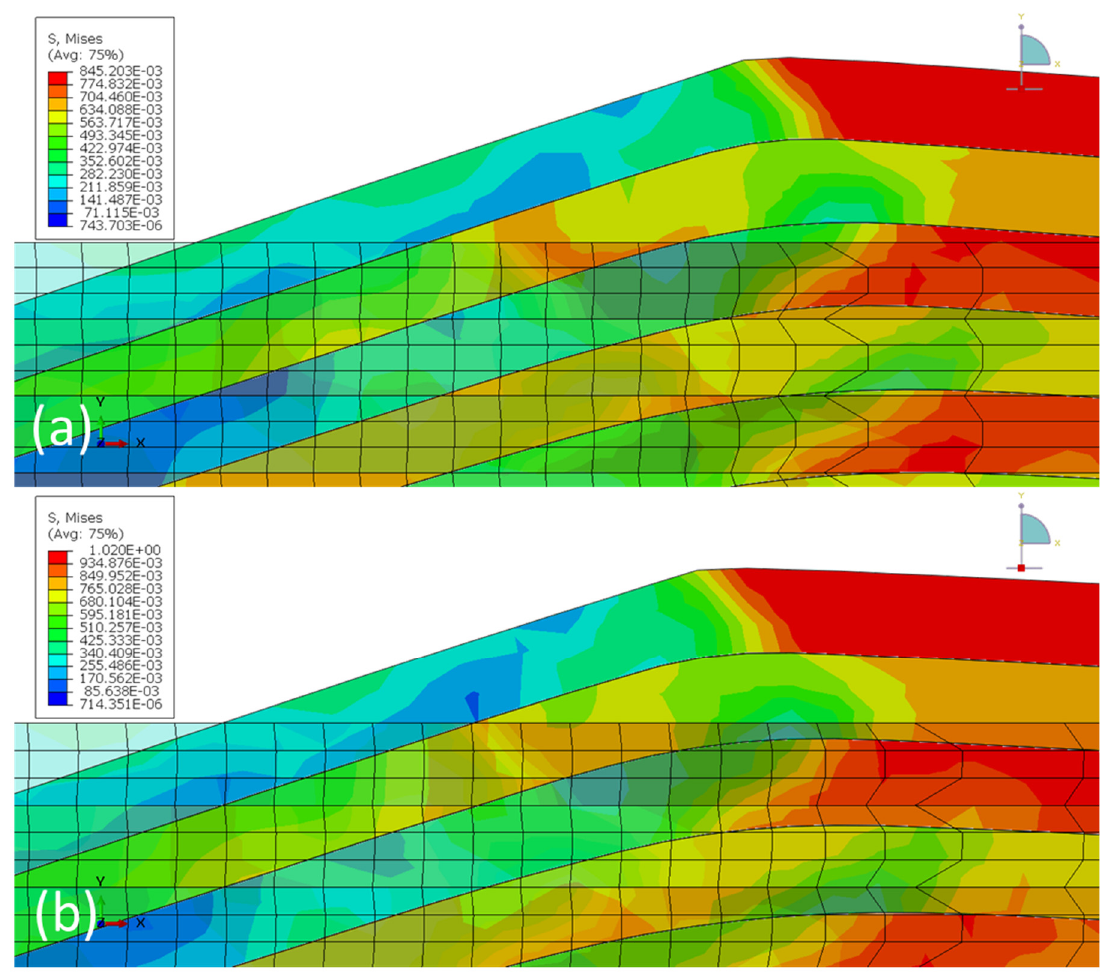
Figure 7. Pile-up distribution along the ( a ) RD and ( b ) TD for an indenter depth of 400 nm. The figure shows initial surface of the sample (with mesh) and the final surface of the sample (only feature edges) superimposed on each other to depict the pile-up. The corresponding videos (Video S1 to Video S6) of the evolution of von Mises’s stress along the TD and RD of the Cu(16)/Nb(16) ARB nanolaminate for all indentation depths are included in the Supplementary Materials. Furthermore, the figures depicting pile-up distribution for nanoindentation depths 200 and 300 nm are also included in the Supplementary Materials. The unit of the data shown in the legend is GPa.